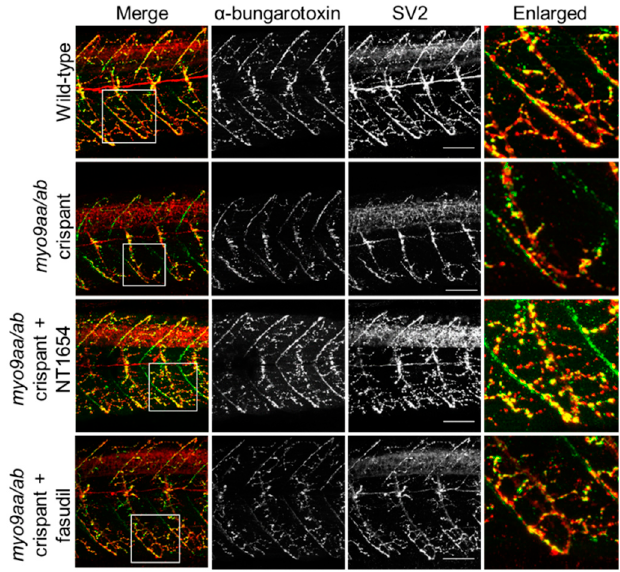
Figure 4. NMJ morphology of myo9aa / ab crispant zebrafish at 48 hpf. Representative images of NMJs in wild-type, myo9aa / ab crispant, and NT1654 (0.15 ng) or fasudil-treated (10 µ m) crispant zebrafish at 48 hpf. Acetylcholine receptors stained with α BTx (green), and motor neurons detected with an antibody against SV2 (red). White boxes demark areas enlarged in the right-hand panel. Scale bar = 50 µm.